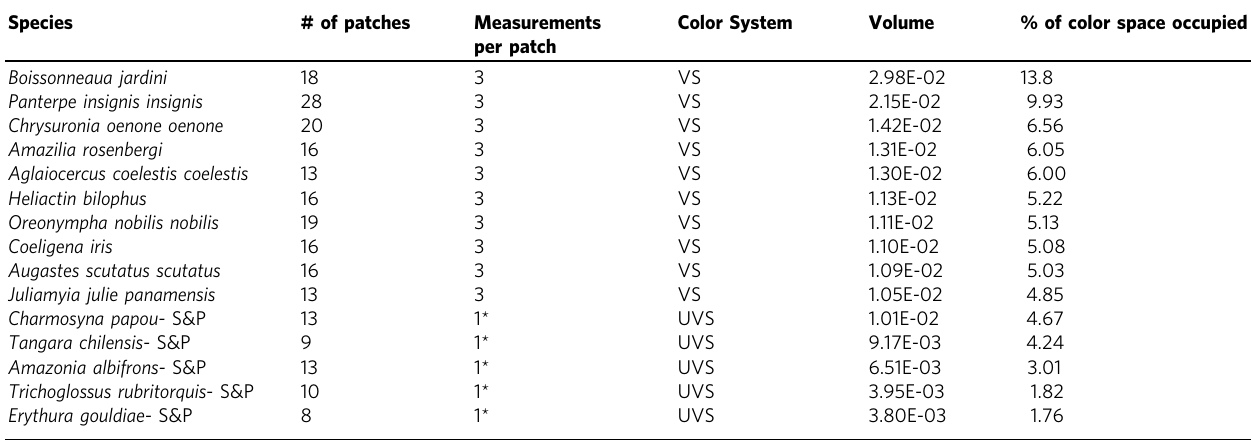
Table 2 Comparison of the 15 largest species color gamuts from this study and Stoddard and Prum (2011). Species # of patches Measurements